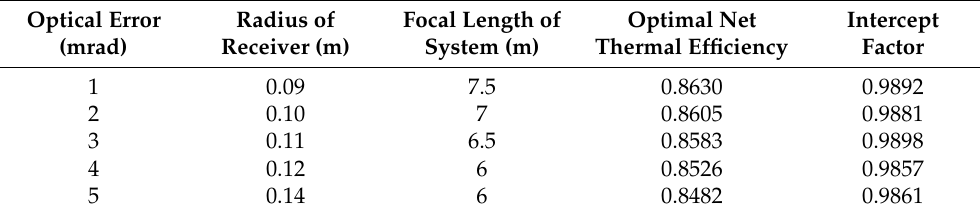
Table 2. The optimal annual net thermal efficiency and optimized parameters of the multi-dish system for optical errors ranging from 1–5 mrad; each focus length of the mirror is equal to the distance from the receiver.